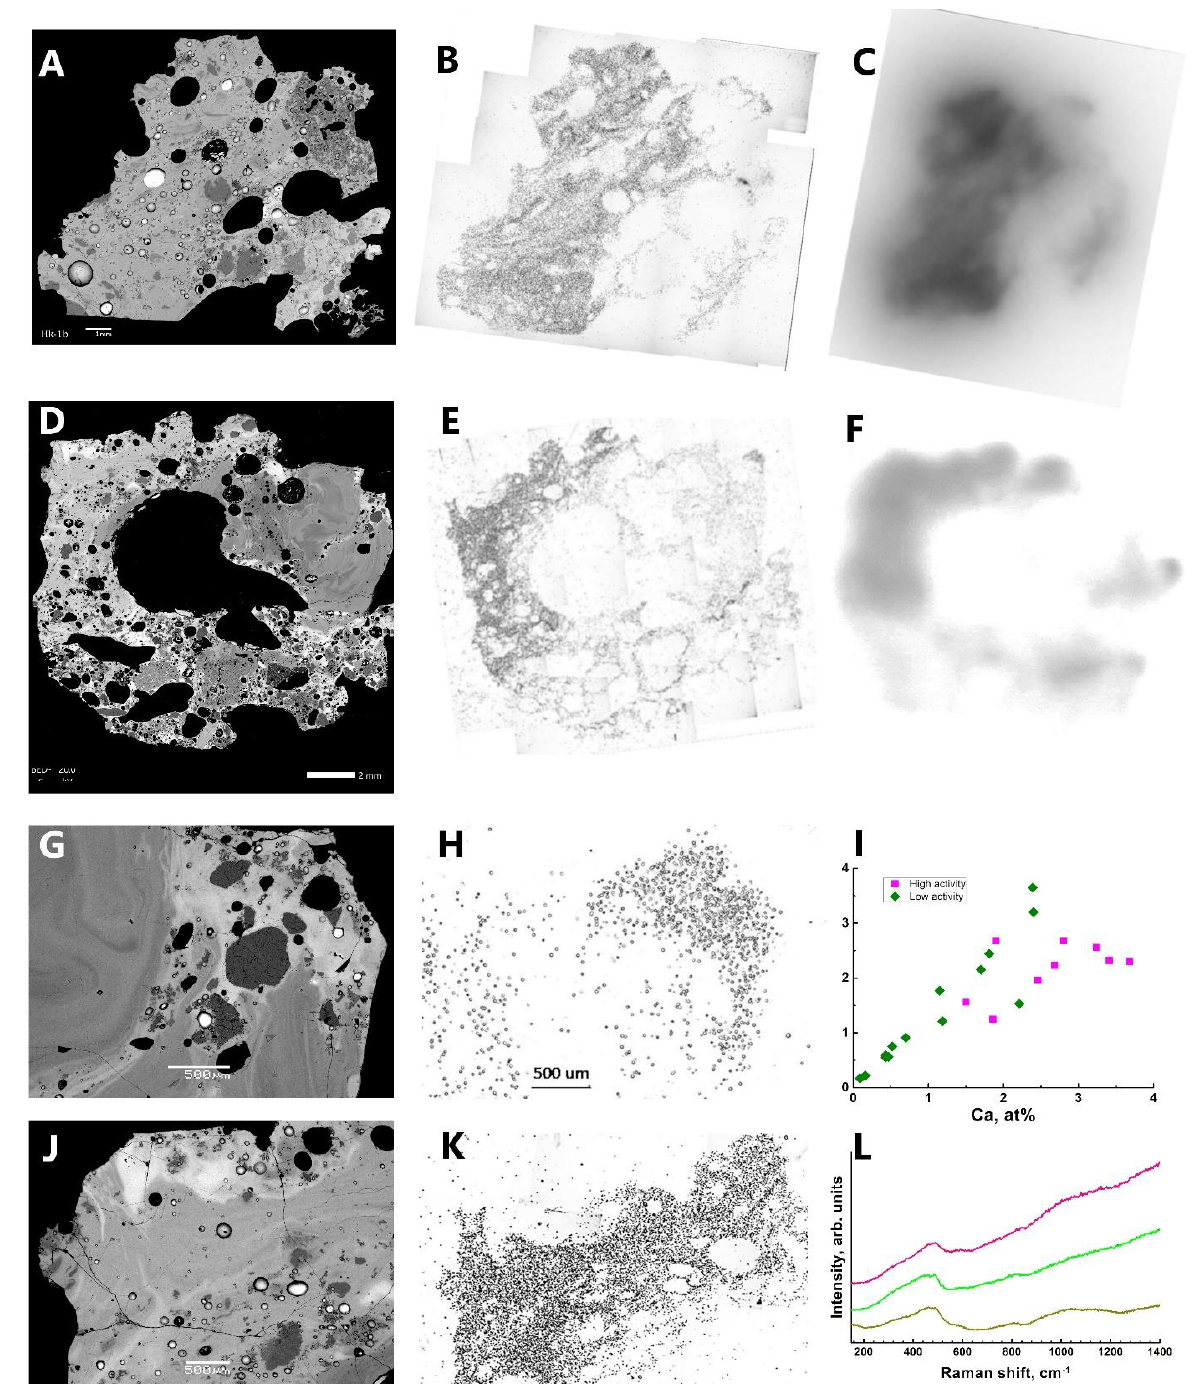
Figure 7. Ground glass particles HK-1b ( A – C ) and HK-2a ( D – L ); SEM-BSE ( A , D , G , J ), alpha track radiographs (exposure time: 6 days ( B , E , H , K )), imaging plate (exposure time: 6 days ( C , F )). SEM-BSE and alpha track images of the selected areas of HK-2a with low- and high-activity glasses ( G , H , J , K ) Raman scattering spectra ( L ) and Ca-Fe content in points with different activity ( I